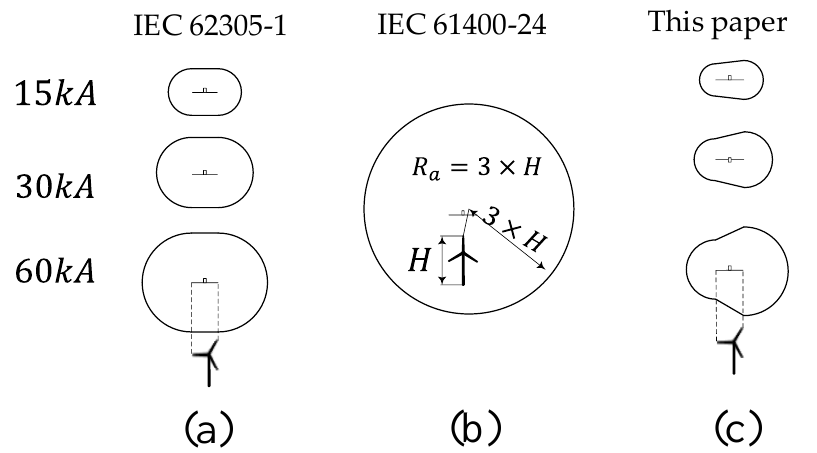
Figure 11. The schematic diagram of 𝐴 𝑒 evaluated from the various models ( a ) IEC 62305-1, ( b ) IEC 61400-24, ( c ) In this study.